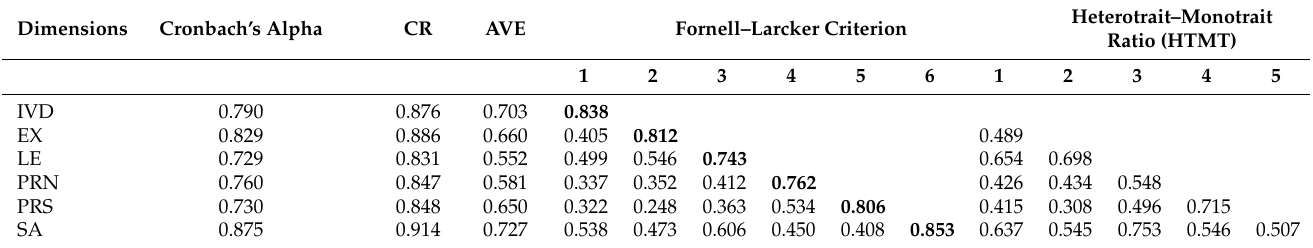
Table 4. Reliability, construct validity and discriminant validity.